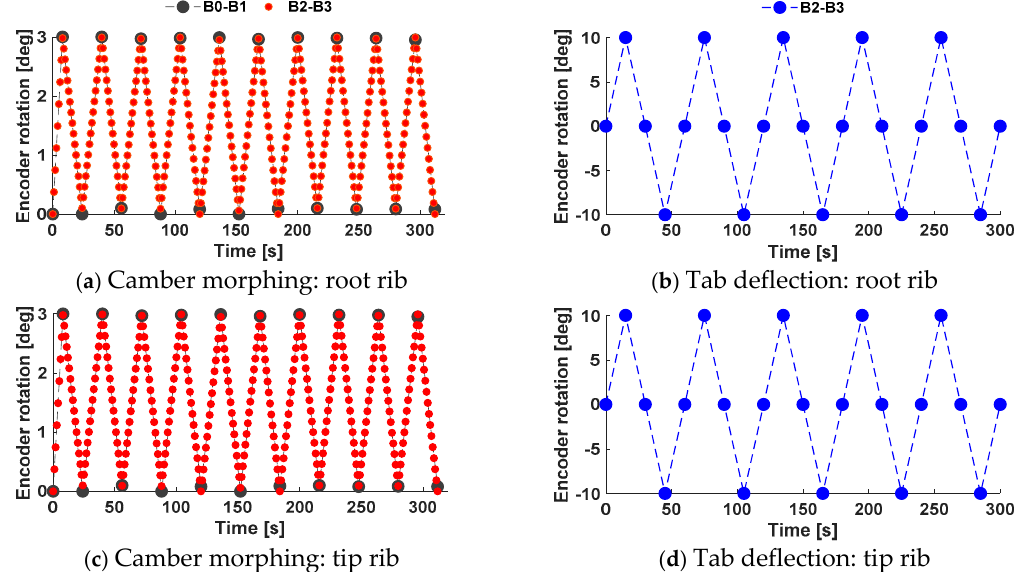
Figure 16. Flap configurations functionality test.